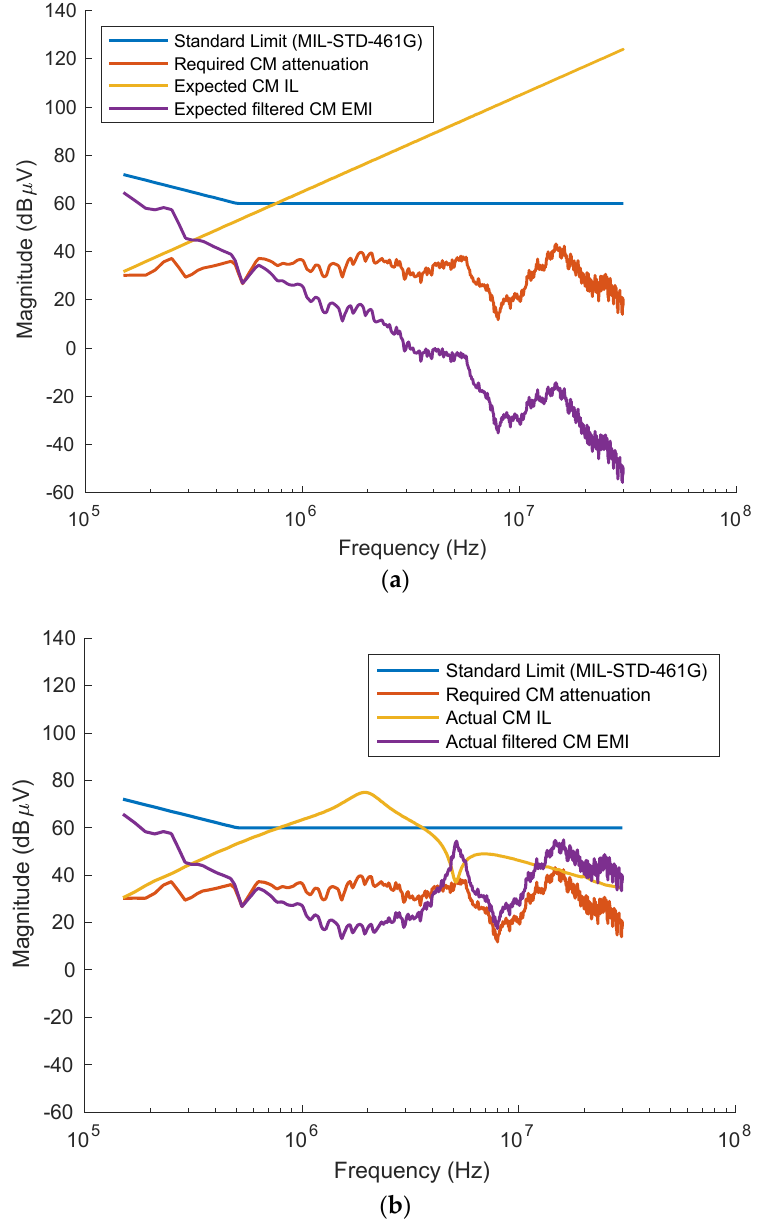
Figure 11. CM performance of the filter designed using [25]: expected ( a ) and actual ( b ).